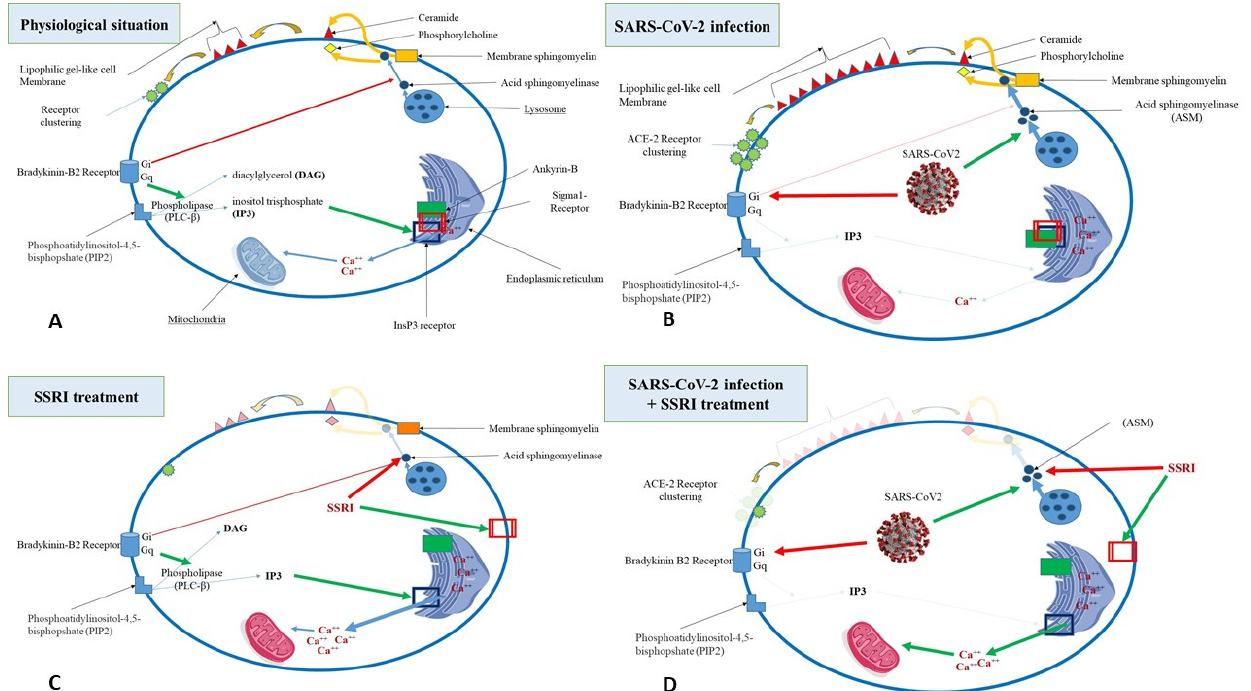
Figure 1. Interactions between the bradykinin receptors (BDKRB 1 and 2) and the presumed key cell molecules implicated in the beneficial effects of the selective serotonin-reuptake inhibitor (SSRI) antidepressants in severe acute respiratory syndrome coronavirus-2 (SARS-CoV-2)-infected patients. Four patterns are represented including ( A ) the baseline physiological, ( B ) the SRRI treatment, ( C ) the SARS-CoV-2 infection, and ( D ) the SARS-CoV-2 infection with the SRRI treatment situation. SARS-CoV-2 infection stimulates the release of acid sphingomyelinase (ASM) from cell membranes, leading to an increase in ceramide production and angiotensin-converting enzyme-2 (ACE2) clus- tering that enhances SARS-CoV-2 entry in the targeted cells. In parallel, SARS-CoV-2 infection decreases bradykinin production, thus decreasing BDKRB2 stimulation, calcium release from the endoplasmic reticulum, and adenosine triphosphate production from mitochondria. Treatment with SSRI antidepressants, known as functional inhibitors of acid sphingomyelinase, inhibits ASM release, thus decreasing ceramide production, which results in ACE2 clustering and the depression of SARS-CoV-2 cell entry. In the SARS-CoV-2-infected cells, SSRI antidepressants stimulate sigma-1 receptors, which results in the dissociation of ankyrin-B from inositol 1,4,5-trisphosphate receptors (InsP3R), thus increasing BDKRB2 stimulation, which increases the effects of inositol-3-phosphate (IP3) on the InsP3R, subsequently increasing calcium release from the endoplasmic reticulum and adenosine triphosphate production from mitochondria. Colors are lightened in the case of inhibition or reinforced in the case of stimulation. Green arrows represent stimulation, red arrows represent inhibition, blue arrows represent transfer, and yellow arrows represent a biochemical process.